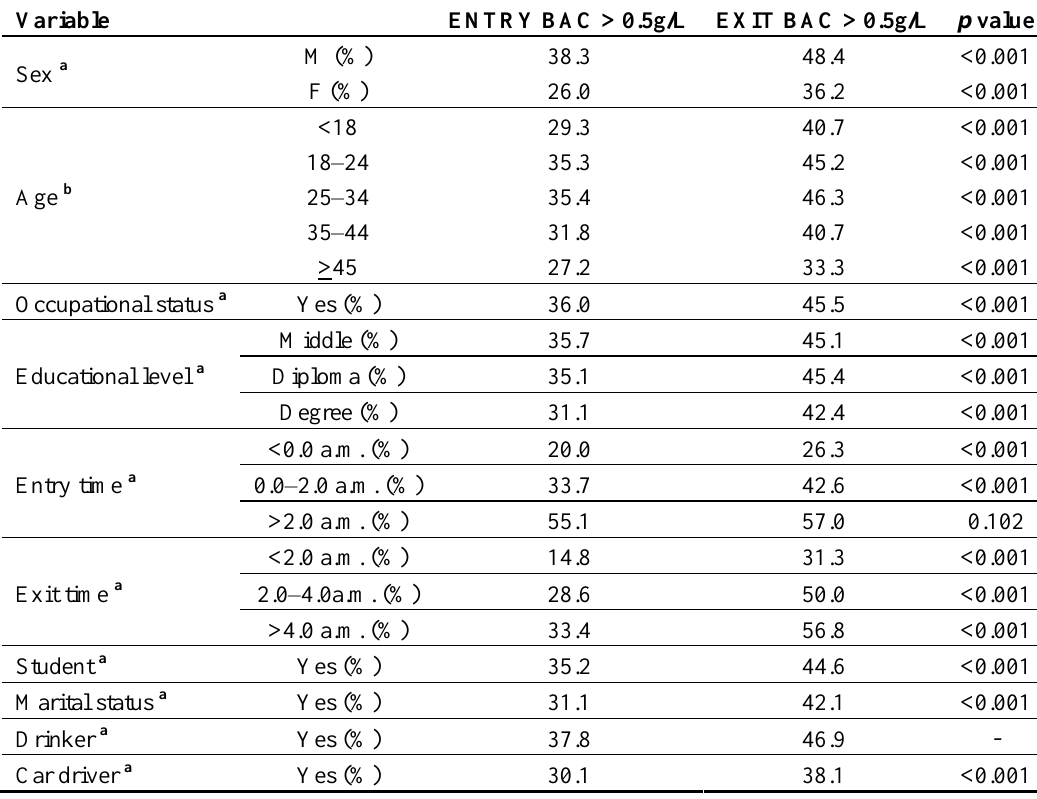
Table 3. Sociodemographic and environmental characteristics of all the participants influencing BAC values measured at the entry to and at the exit from the discos (or other recreational